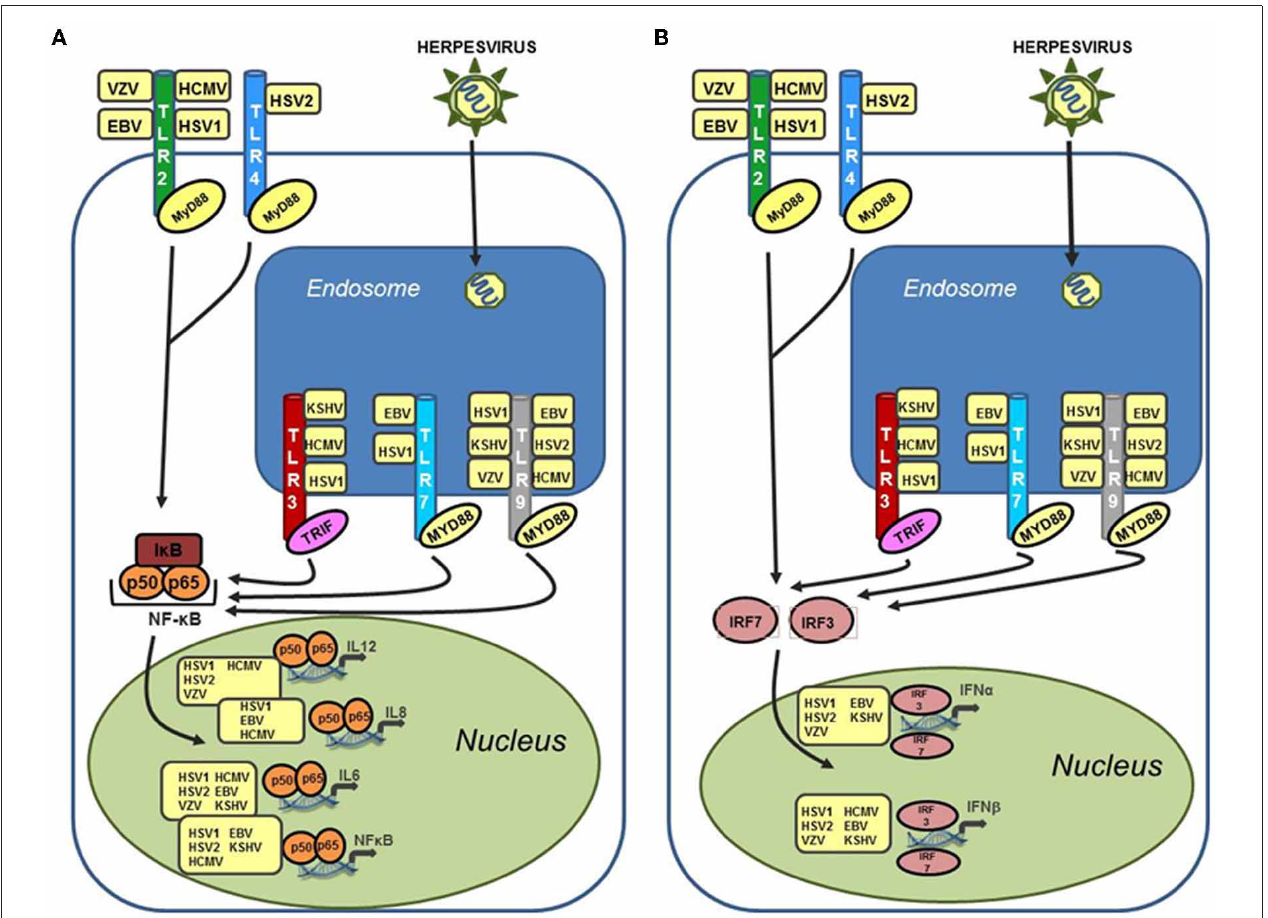
FIGURE 1 | Human herpesviruses can stimulate a wide variety of TLRs leading to upregulation of both inflammatory cytokines and type I interferon. (A) Activation of NF- κ B and inflammatory cytokines (IL-6, IL-8, and IL-12) via TLR stimulation by human herpesviruses. TLR stimulation results in activation of NF- κ B in the cytoplasm and subsequent translocation to the nucleus where it serves as a transcriptional activator for a large number of inflammatory cytokines. Activation of these cytokines can occur after